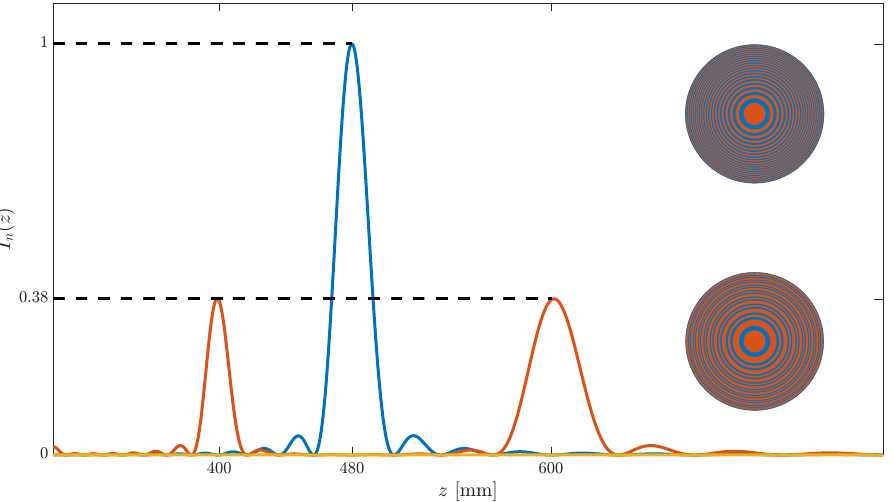
Figure 5. Normalized focusing profiles vs. axial coordinate for the conventional Fresnel ZP (blue), bifocal ZP (red) and no lens (yellow) cases. Insets depict the ZP layouts for the Fresnel ZP (top) and bifocal ZP